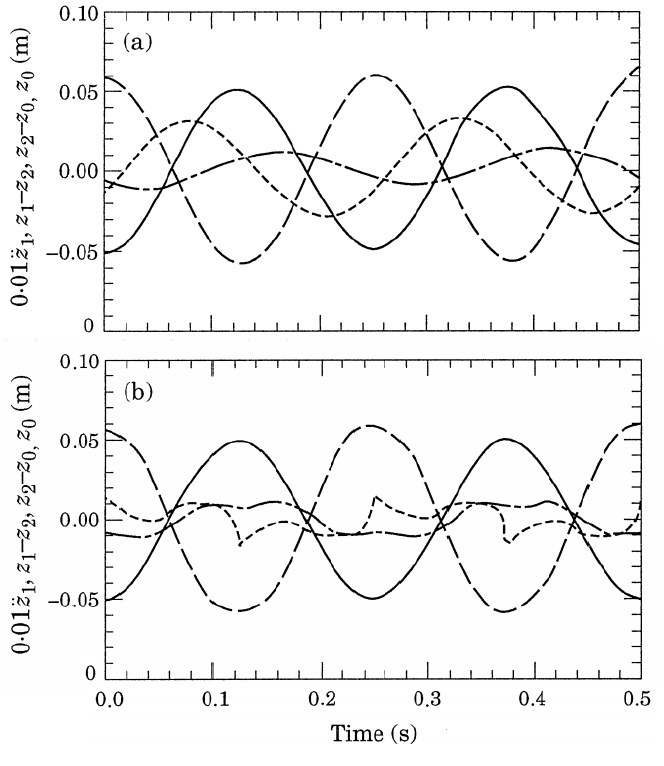
Figure 1. Steady-state response of a semi-active pneumatic suspension system to a harmonic input of frequency 25 (rad/s), body acceleration 0.01¨ z 1 : - - - - - - , suspension deflection ( z 1 − z 2 ) : – – – – – , tire deflection ( z 1 − z 0 ) : – - – - – - , road input z 0 : ——— ; ( a ) without preview ( b ) with preview 0.1